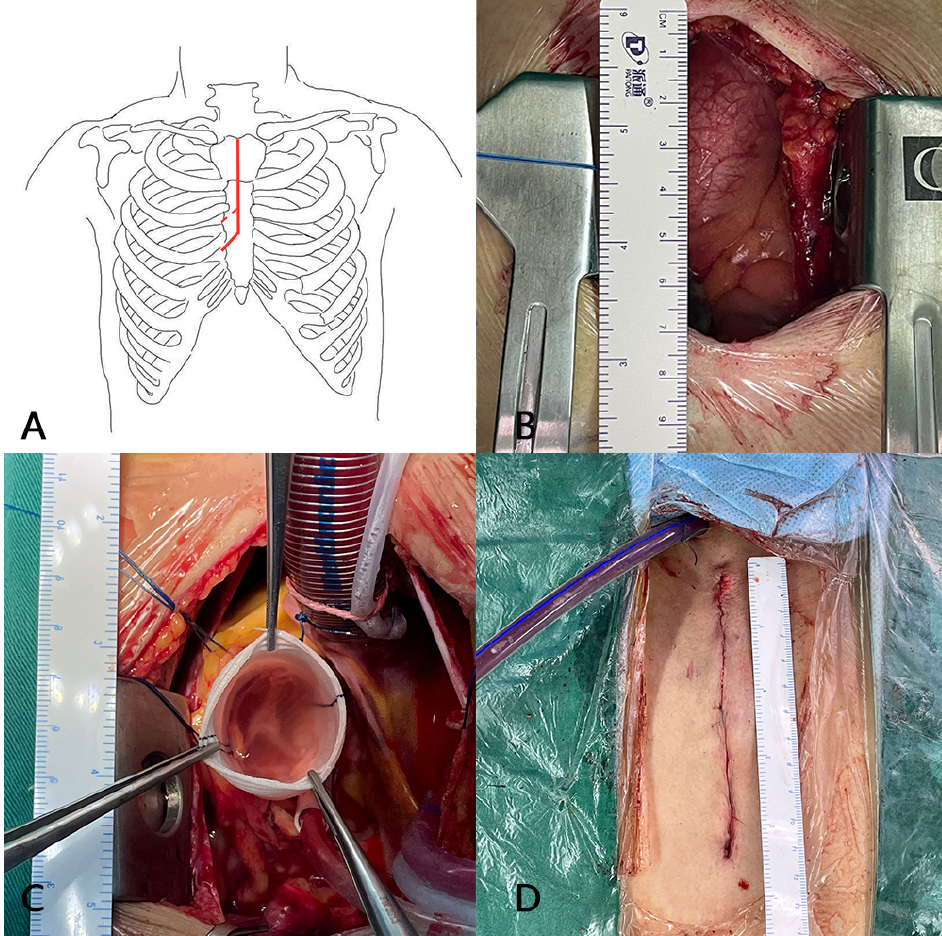
Figure 2. Minimally invasive access through partial upper sternotomy for the VSRR procedure showing the pattern ( A ), incision ( B ), aortic valve assessed by a water injection experiment ( C ), and suture ( D ).